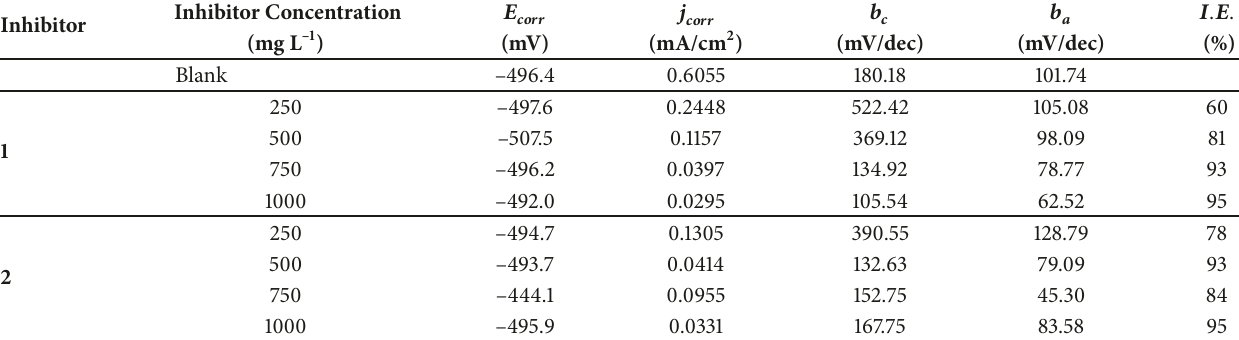
Figure 5: Potentiodynamic polarization curvesof carbon steelin 1.0 mol L – 1 HCl solution in absenceand presenceof different concentrations if inhibitor 1 (a) and inhibitor 2 (b). Table 7: Electrochemical parameters of carbon steel in 1.0mol L – 1 HCl aqueous in absence and presence of inhibitors at different